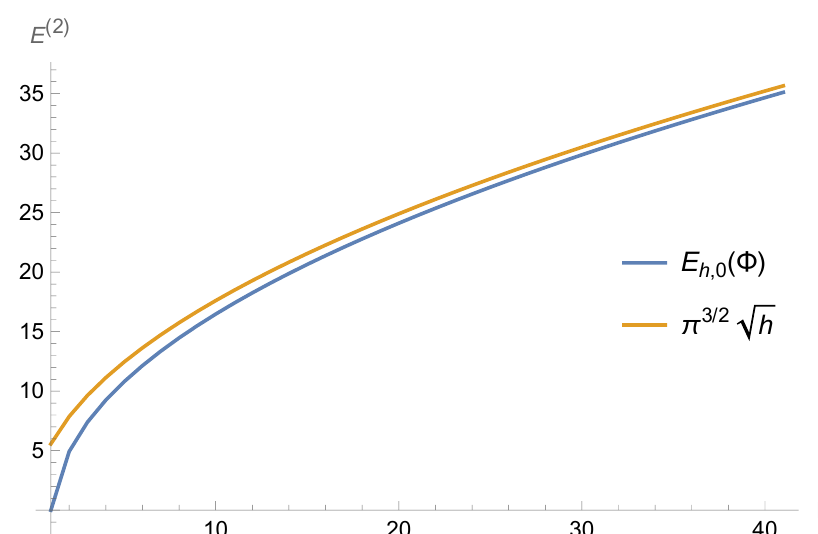
Figure 1 : The second-order energy lift (3.44) for states of the form (3.2), with N = 2 , as a function of the superconformal primary’s dimension h . The plot shows the behavior of the lift for large h √ and an asymptotic h behaviour is